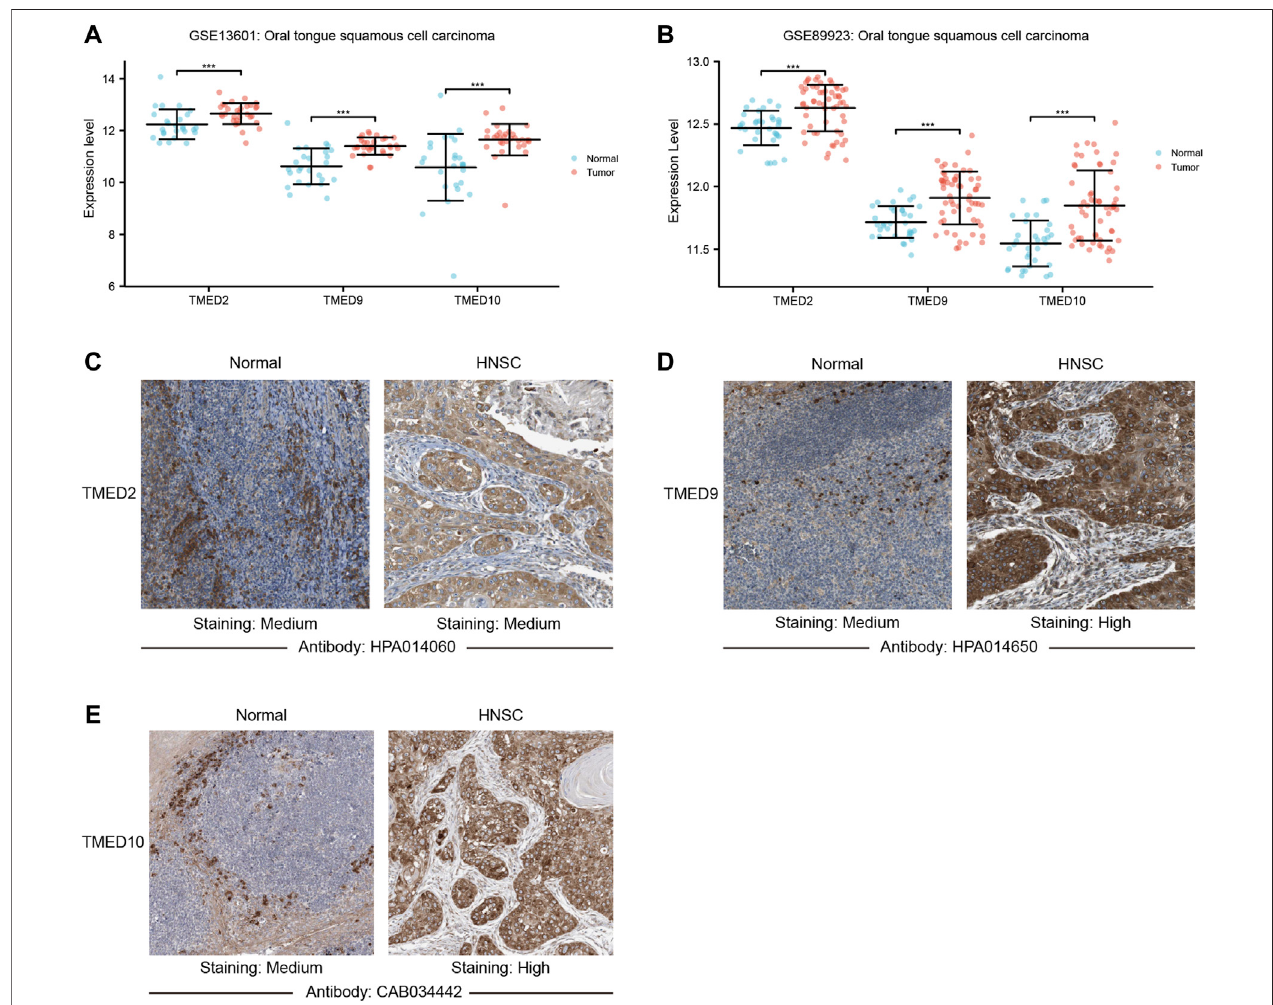
FIGURE 4 | The mRNA expression levels between tumor and non-tumor tissues in head and neck squamous cell carcinoma (HNSC) patients in the GEO dataset including (A) GSE13601; (B) GSE89923 (***, p -value < 0.001). Protein expression levels of TMED2/9/10 in normal head and neck tissues and HNSC of The Human Protein Atlas. (C) TMED2; (D) TMED9; (E)